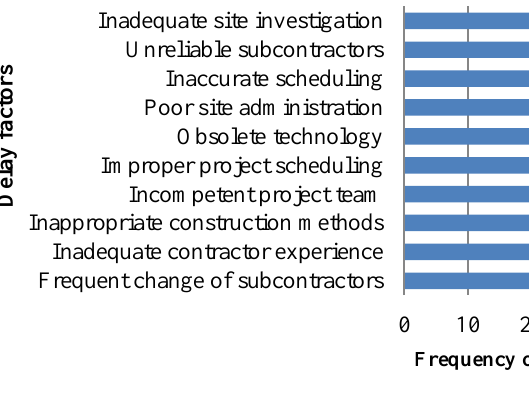
Fig. 3. Frequency of consultant-related delay factors [figure made by authors].